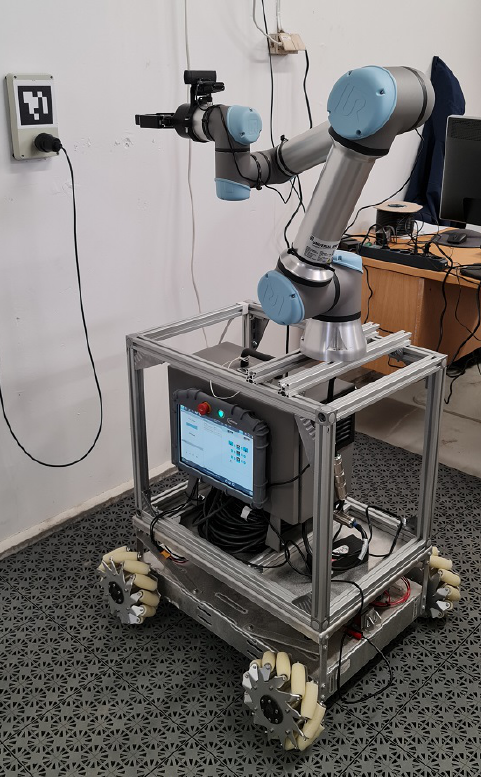
Figure 1. The Autonomous Charging Station composed of: A collaborative robot arm equipped with a gripper and an RGB camera, an aluminum frame, and an omnidirectional mobile